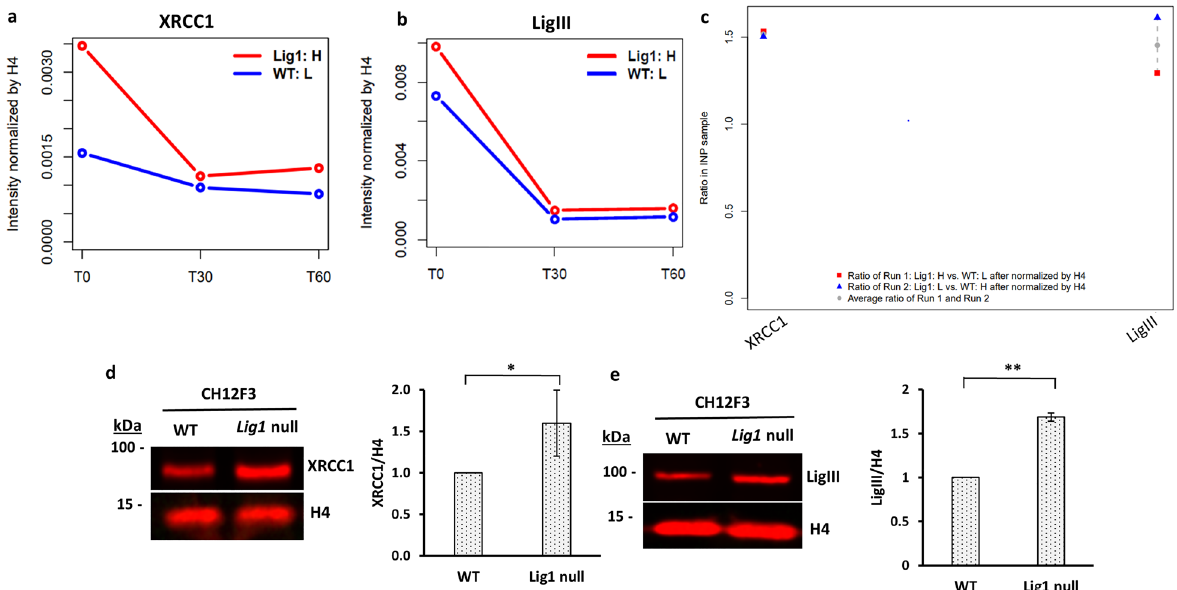
Figure 4. Increased association of XRCC1 with replicating DNA and higher levels of chromatin bound XRCC1 and LigIIIα in LIG1 null cells. The relative levels of ( a ) XRCC1 and ( b ) LigIIIα associated with EdU-labeled DNA in CH12F3 wild type cells (WT:L, blue line) and a LIG1 null derivative (LigI:H, red line) were determined by mass spectrometry as described in “Materials and methods”. (c) The levels of XRCC1 and LigIIIα in the bulk chromatin are shown as a ratio of LIG1 null to WT cells in two independent experiments (red square and blue triangle) and their average (grey dot). Immunoblotting of; (d) XRCC1 and; (e) LigIIIα in chromatin fractions from CH12F3 wild type cells and a LIG1 null derivative. Histone H4 immunoblot is shown as a loading control for chromatin. Data shown graphically are the mean ( ±) SEM of three independent experiments. Unpaired two-tailed Student test. ‘*’ P-values < 0.05, ‘**’ = P-values < 0.01. Uncropped Western blots are shown in supplementary Fig